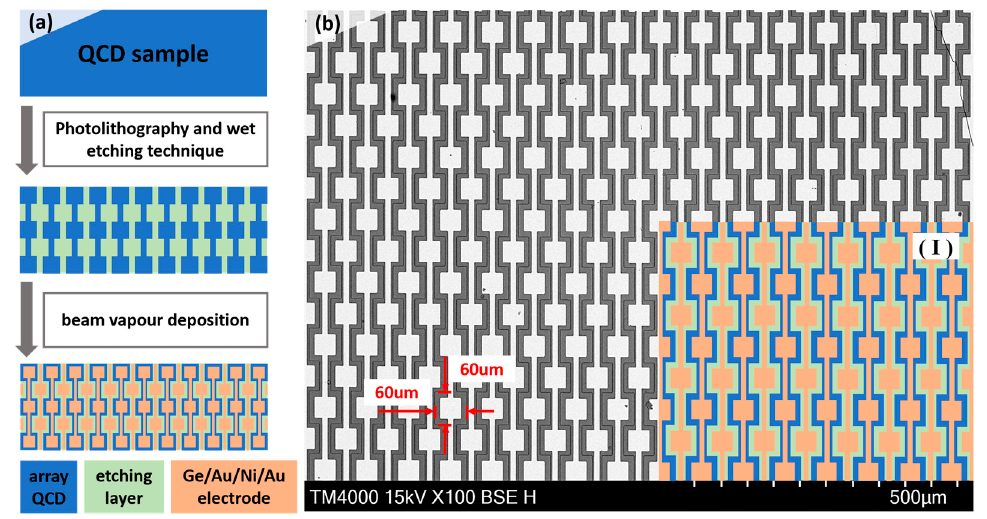
Figure 1. Array QCD structure. ( a ) The preparation steps of the array QCD. ( b ) The SEM of array QCD. The area of each unit is 60 × 60 um, as marked by the red ruler. Inset ( Ⅰ ) is the corresponding structure diagram of the array unit.